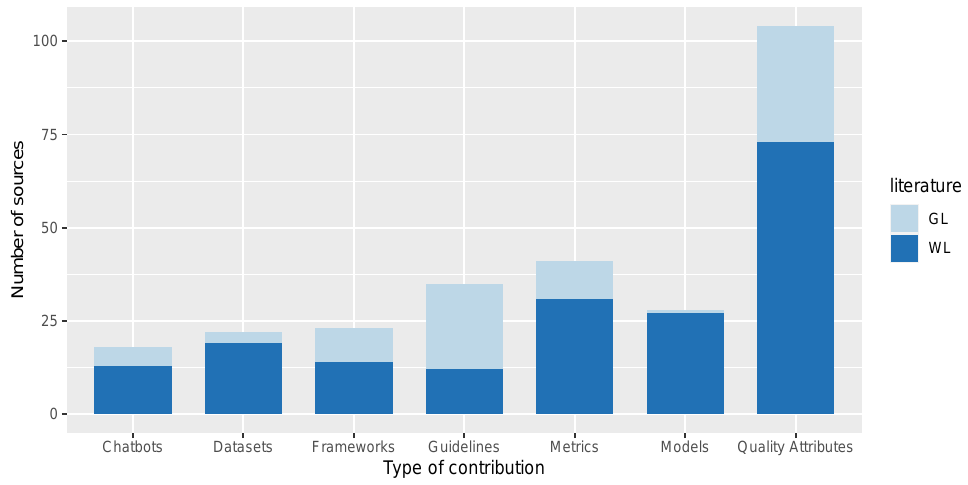
Figure 6. Number of sources for type of